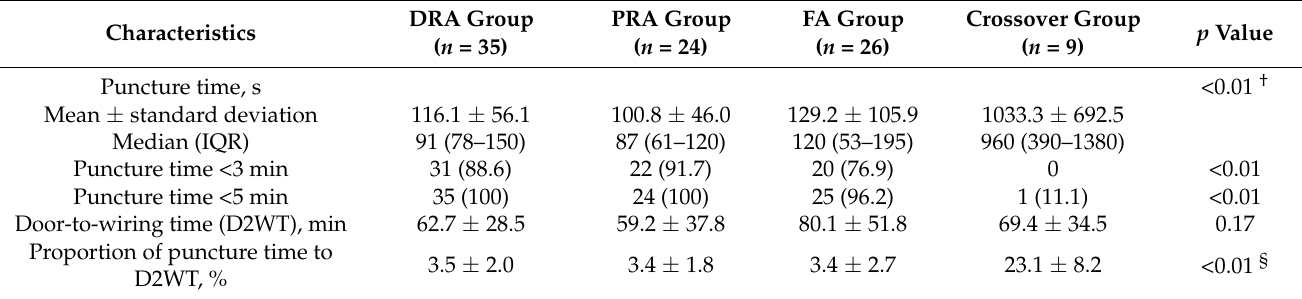
Table 2. Detailed information regarding vascular access routes after separating crossover